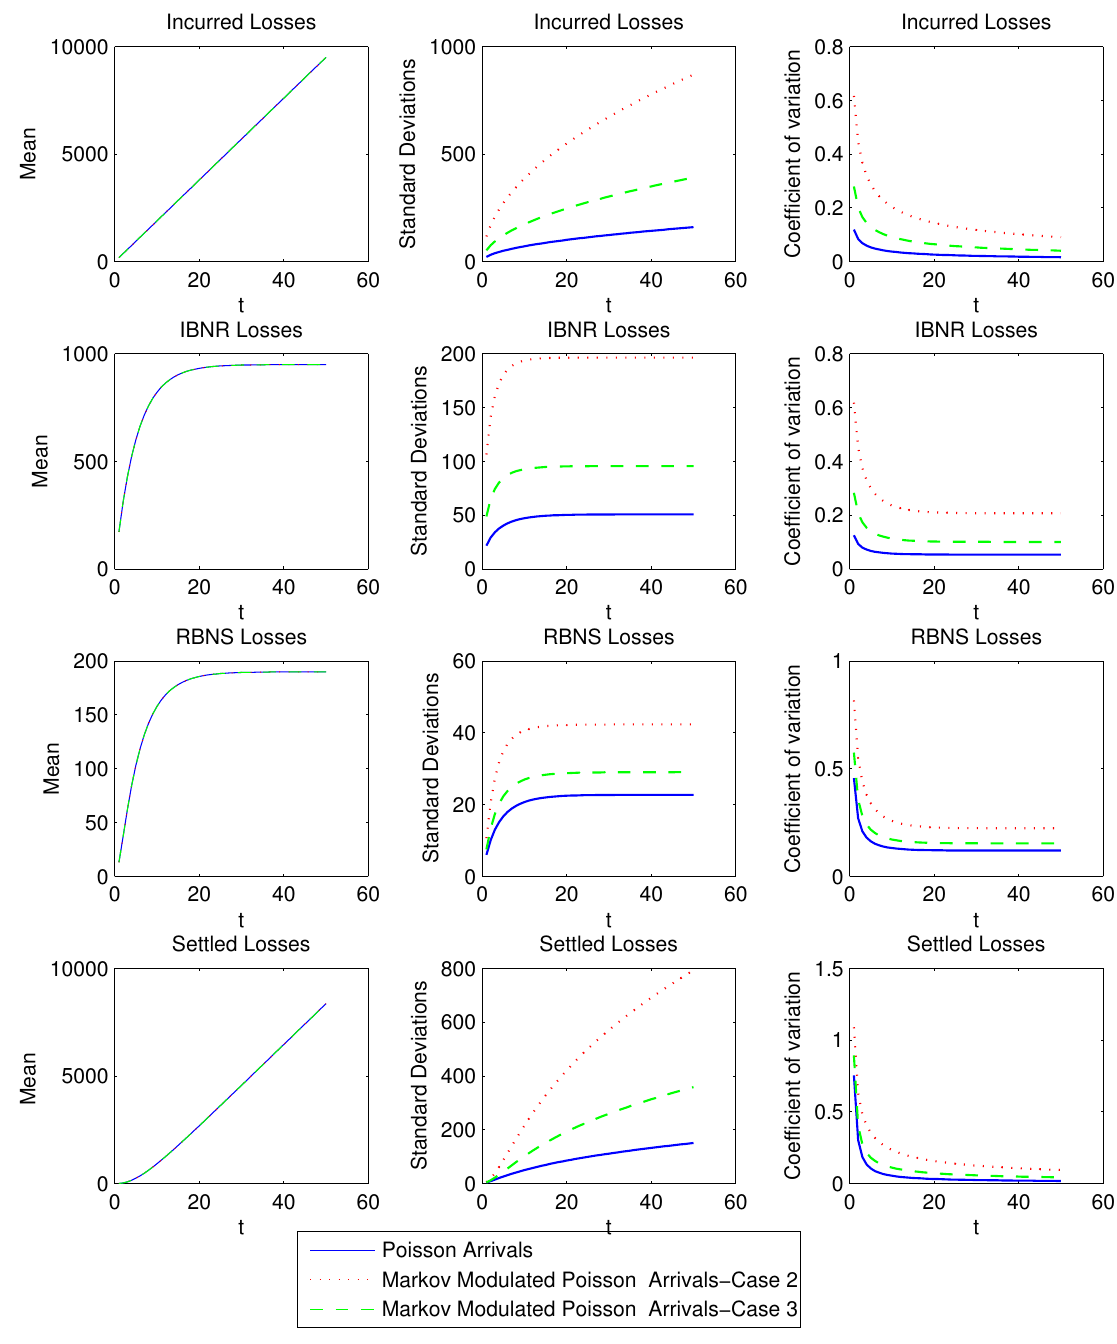
Figure 1. Moments of the claims in different